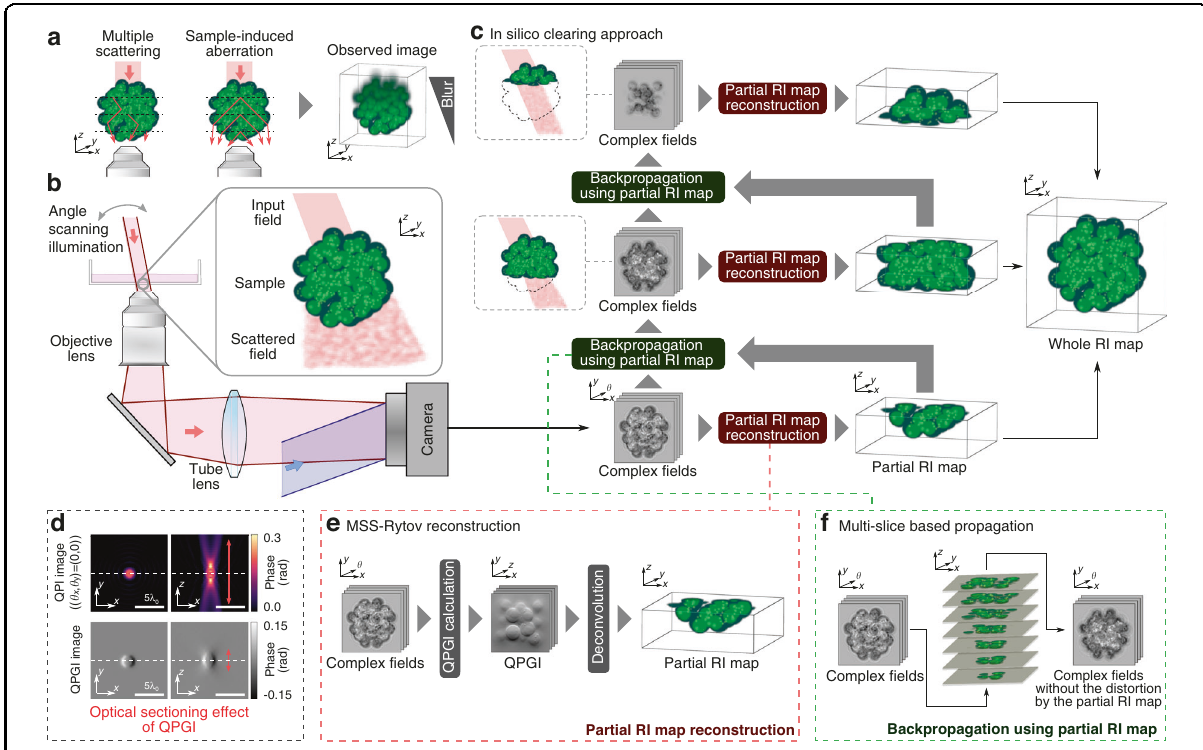
Fig. 1 Overall working principle of in-silico clearing RI tomography. a Two detrimental effects, i.e., MS and SIA, degrade the resolving power of microscopes as the depth increases. b Schematic of the imaging system. Plane waves are irradiated onto a sample at various angles, and the diffracted light is interferometrically captured by a camera. c Pipeline of the in-silico clearing approach. In-silico clearing RI tomography reconstructs a partial RI map near the detection lens from the captured complex fi elds and computationally backpropagates the complex fi elds through the partial RI map. This operation eliminates wavefront distortion caused by the inhomogeneity of the partial RI map, suppresses MS and SIA, and enables unambiguous visualization of the next partial RI map. Repeating this operation till the top of the sample allows entire high-resolution reconstruction. d Quantitative phase imaging (QPI) and quantitative phase gradient imaging (QPGI) of a homogeneous sphere. Images obtained by QPI have a long tail along the optical axis, whereas those obtained by QPGI have a short tail, enabling selective visualization of the sample at a certain depth. e Partial RI map reconstruction using MSS-Rytov, which was proposed previously. MSS-Rytov calculates through-focus QPGI images from multi-angle complex fi elds. This reconstruction scheme takes advantage of the optical sectioning effect of QPGI. f Backpropagation using the partial RI map. In the proposed approach, captured complex fi elds are backpropagated through the partial RI map by multi-slice-based